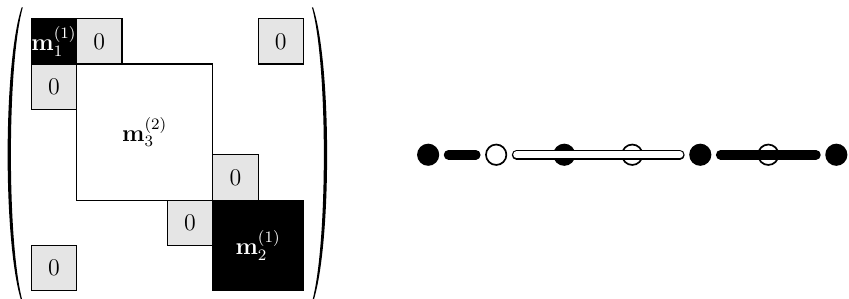
Figure 2: An example for a block matrix associated with a term contained in the monopole contributions (26) for r = 2, k = 3 is shown on the left together with the corresponding diagrammatic representation depicted on the right-hand side of the figure. In the diagram, the color of a line is determined by the color of the node to its